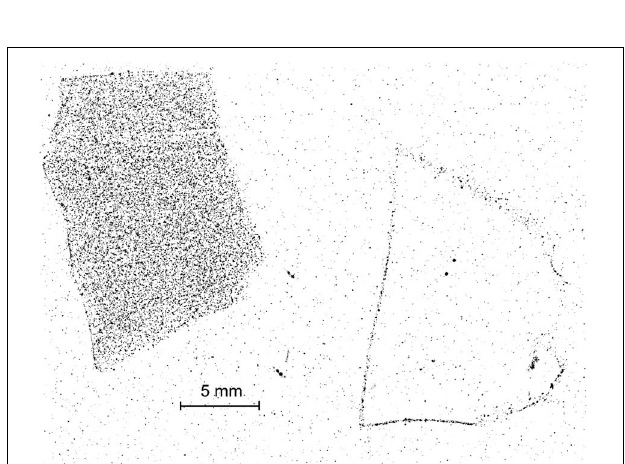
FIGURE 2 | Image of hydrogel pieces in test cell for mode “a” experiment. The image of the piece on the left illustrates the potential for determination of the solid-liquid boundary by method 1, i.e., contrast between the heavily seeded grain and the lightly seeded fluid around the